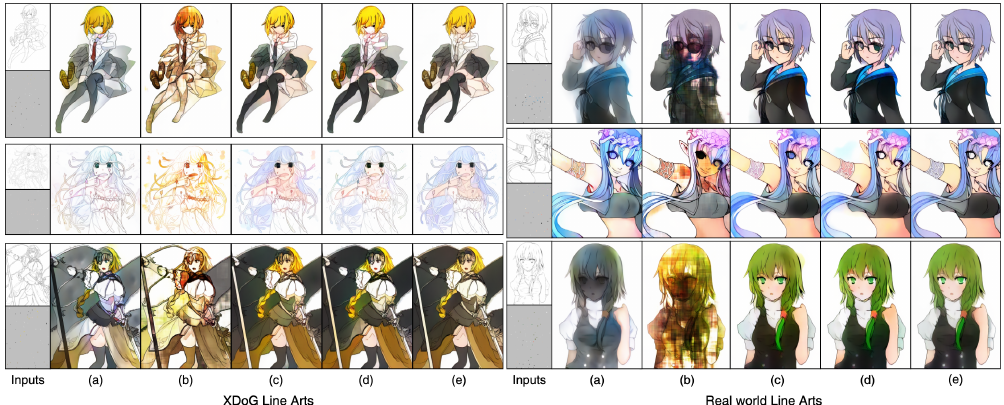
Figure 8. Visual comparison of different models. ( a ): Base [10], ( b ): Pix2pix [2], ( c ): ours (Line Detection Model (LDM) enabled line loss only), ( d ): ours (histogram equalization only), ( e ): ours (Both: LDM enabled line loss + histogram equalization).